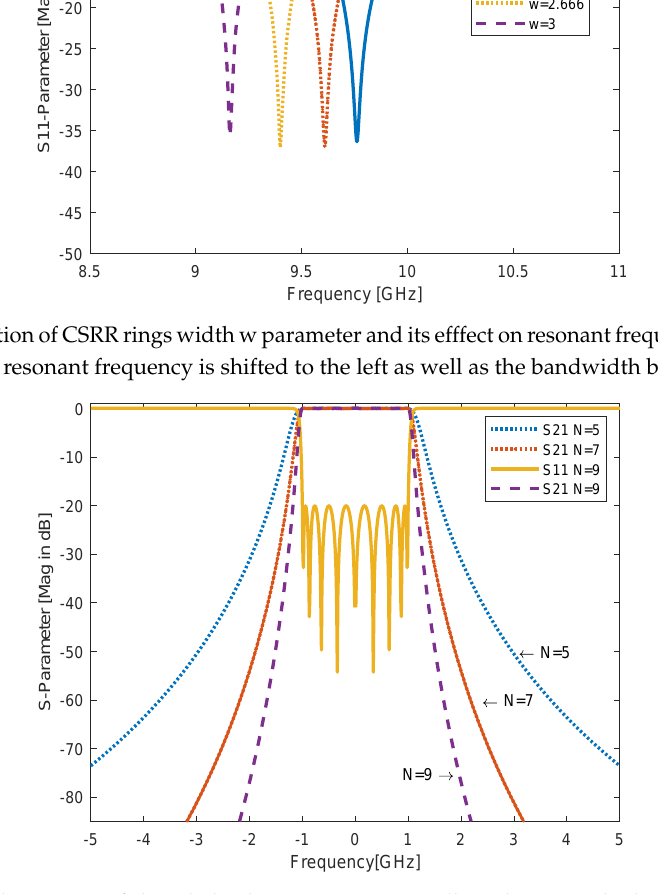
Figure 12. The alternation of the Chebyshev response as well as changing the bandwidth and the sharpness of a filter could be affected based on the number of its resonators, meaning that an increase of filter order N will give more sharpness and enhance bandwidth for N = 5, 7 and 9. Table 1. The influence of changing parameters of the meta-resonator and its effect on cutoff frequency and bandwidth of a bandpass filter, ← response shifts to the left, → response shifts to the right, and ≈ response doesn’t